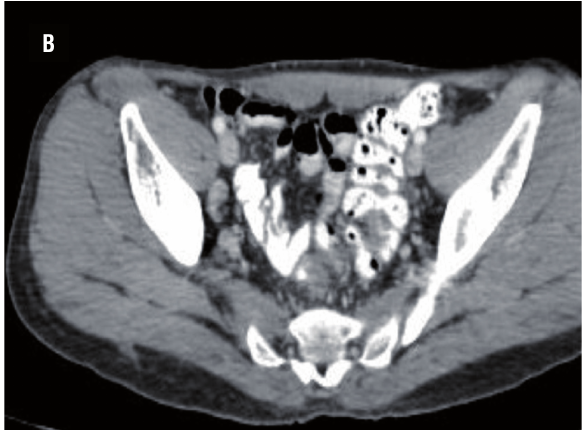
figure 2 - CT showing enlarged lymph node in the pelvis.